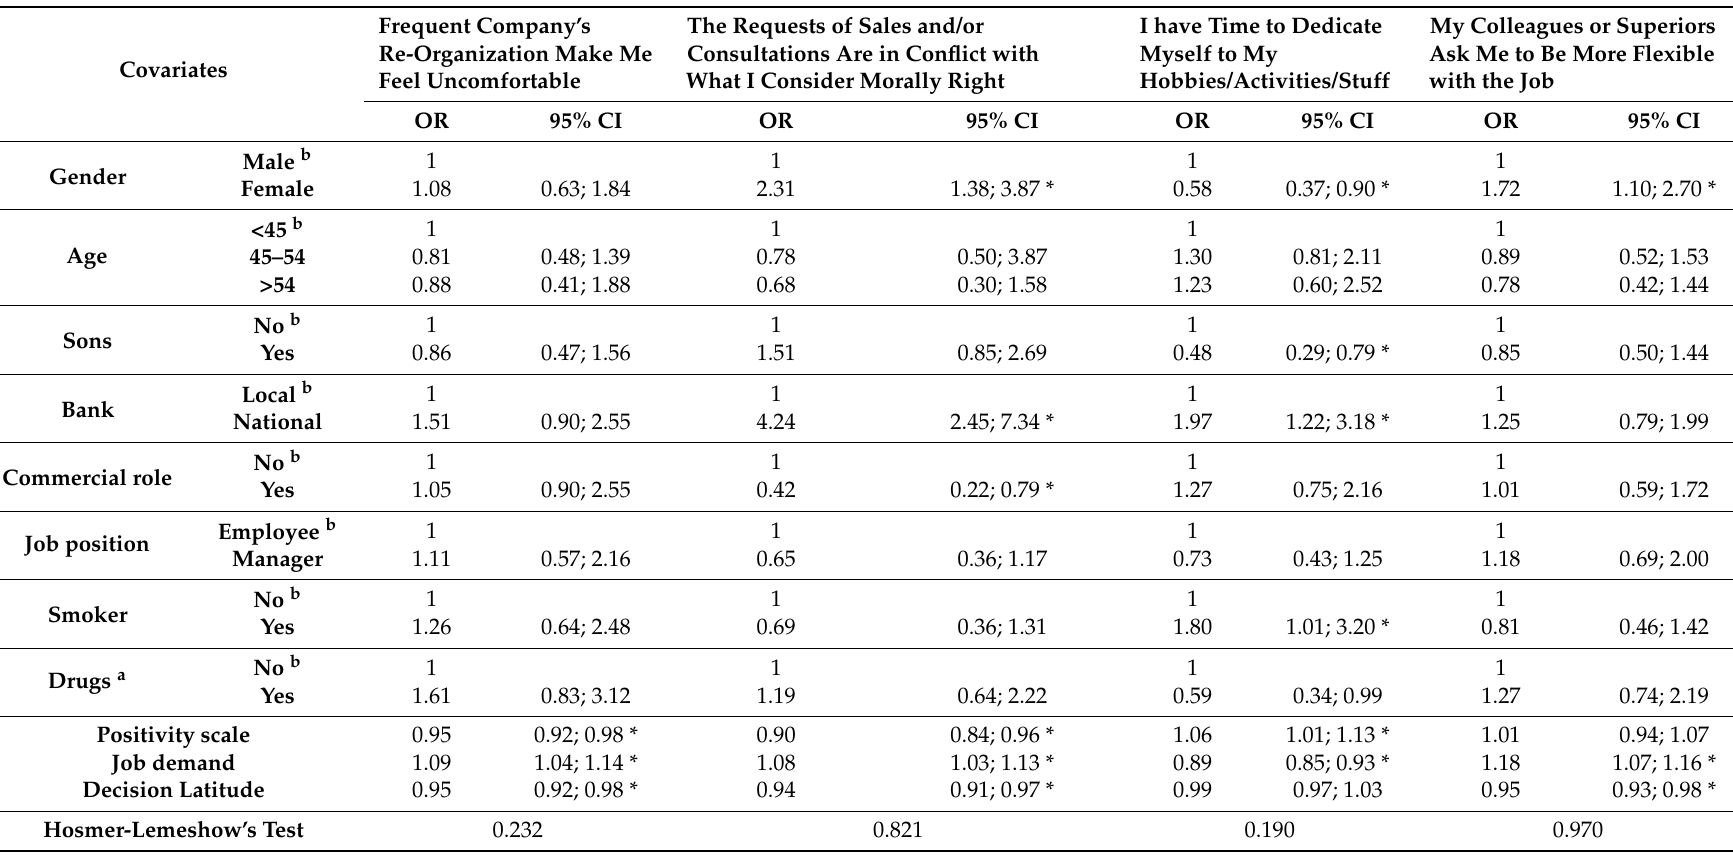
Table 4. Multivariate logistic regression models of the last four BEST8 (cid:48)